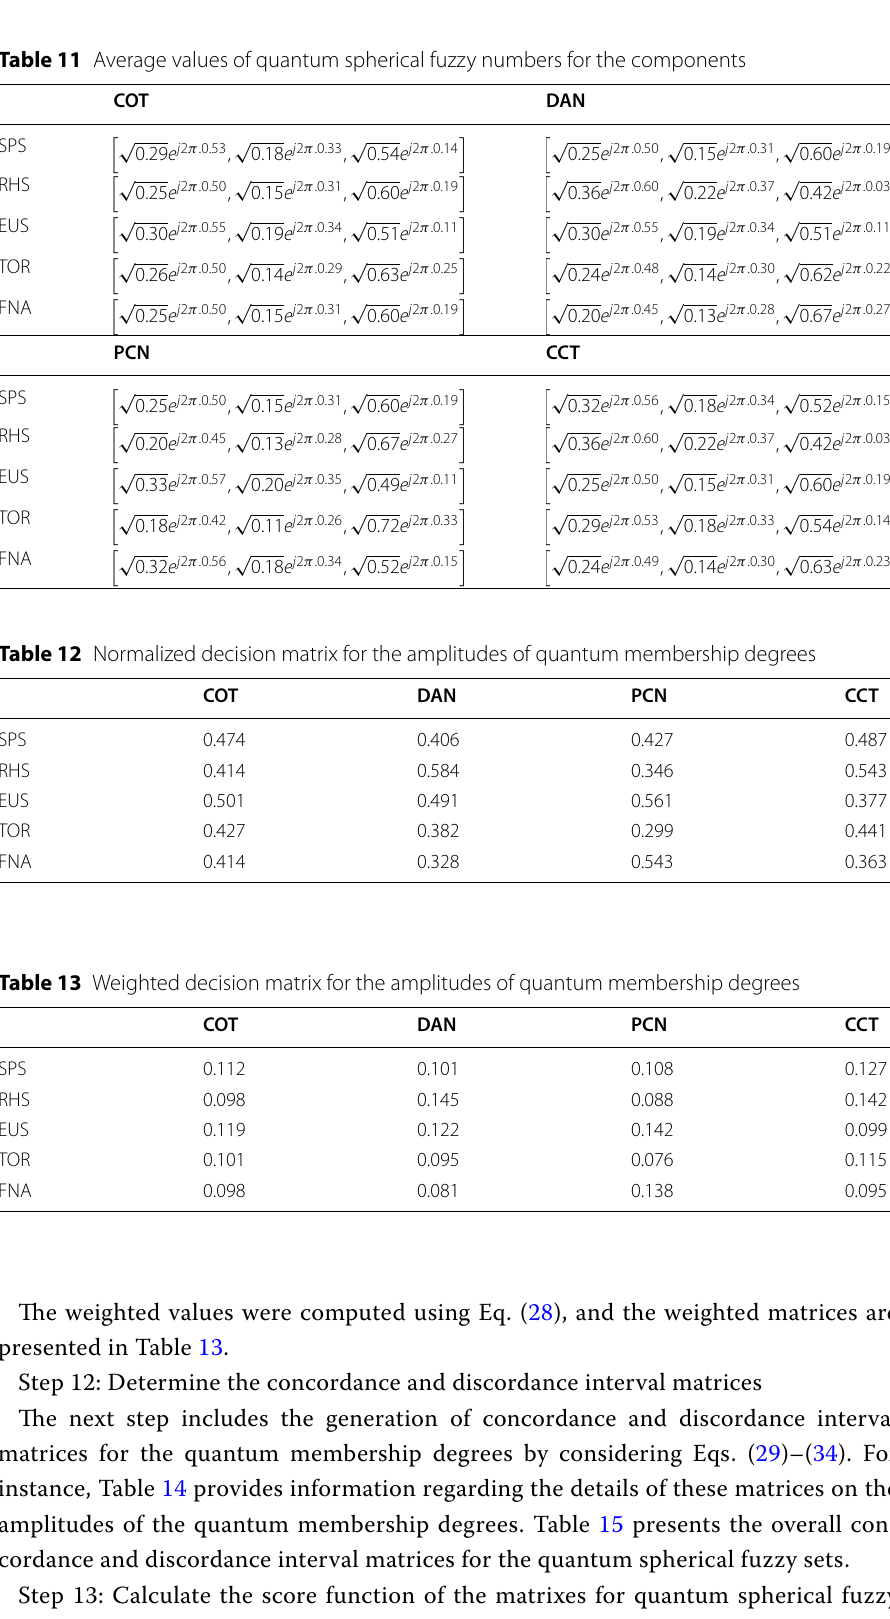
Step 13: Calculate the score function of the matrixes for quantum spherical fuzzy sets